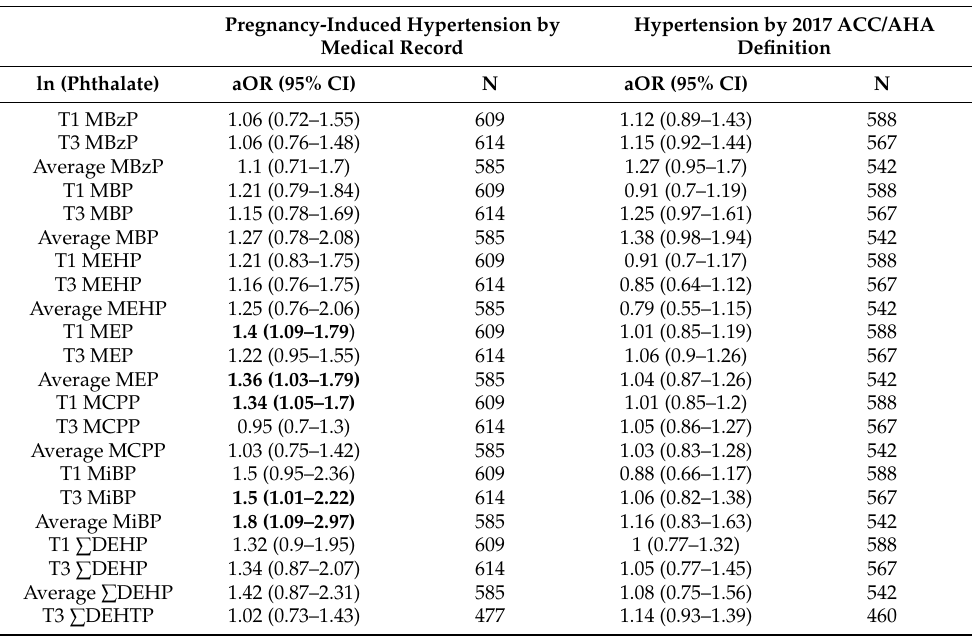
Note: Models were adjusted for study center, race, age at delivery, household income, highest level of education, marital status, cigarette smoking in the first trimester, pre-pregnancy BMI, and parity. Significant results are shown in